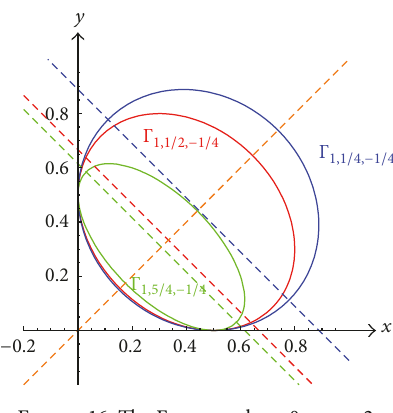
Figure 16: The Γ 1,𝜌,−1/4 , where 0 < 𝜌 < 2 .